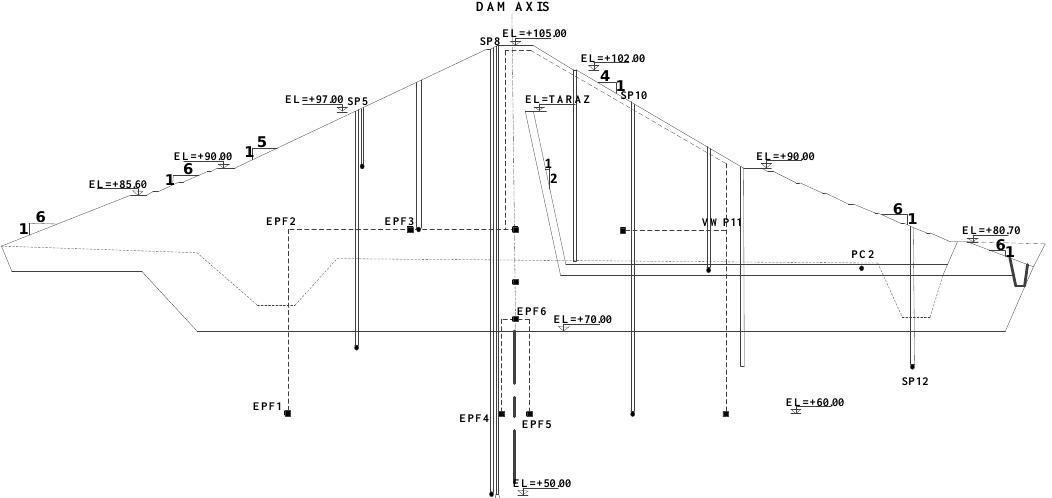
Figure 3. Instrumentation map of Boostan Dam in Section